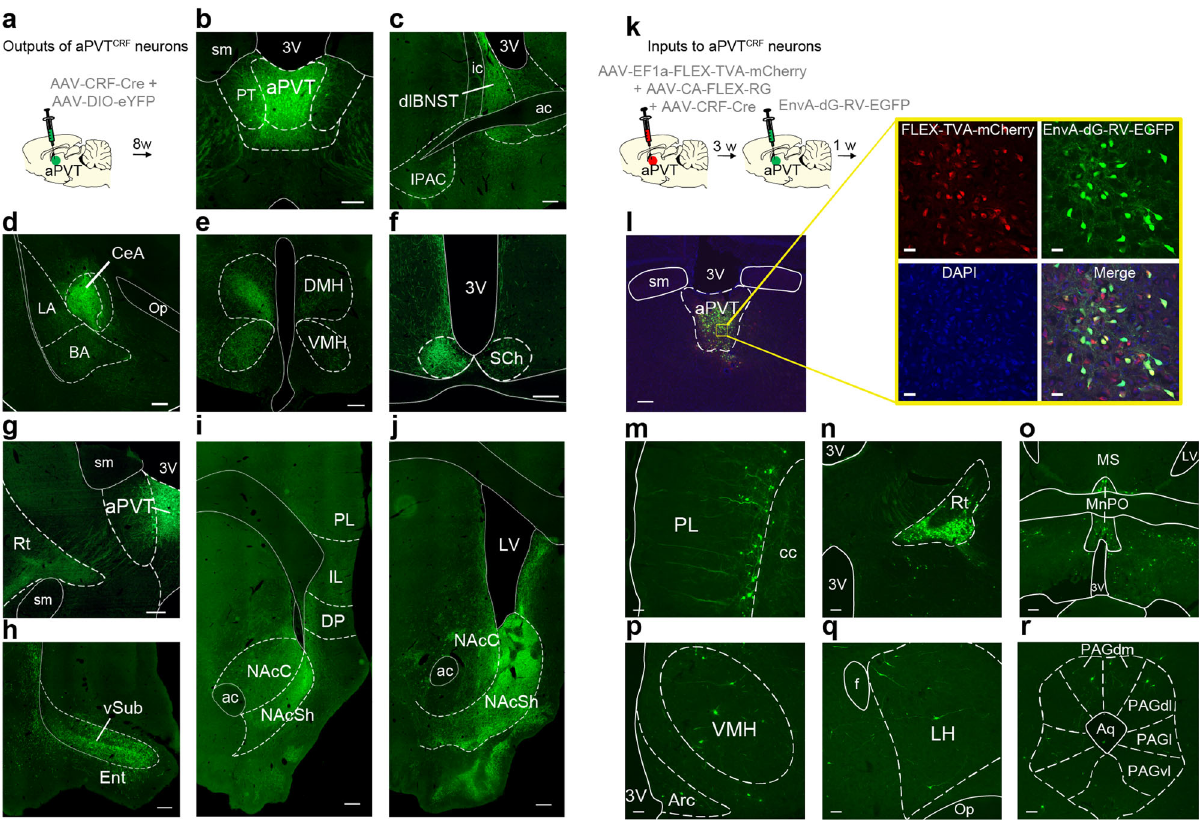
Fig. 6 Afferent and efferent connections of aPVT CRF neurons across the brain. a Schematic of intra-aPVT microinjection of a viral mix containing AAV- CRF-Cre and AAV-DIO-eYFP for speci fi c labeling of aPVT CRF neurons and their fi bers in output regions. b – j Representative micrographs showing the expression of eYFP in b aPVT CRF neurons and their GFP-labeled fi bers located in the c dorsolateral subregion of the bed nucleus of stria terminalis (dlBNST), d central nucleus of the amygdala (CeA), e dorsomedial hypothalamus (DMH), and ventromedial hypothalamus (VMH), f suprachiasmatic nucleus of hypothalamus (SCh), g reticular thalamic nucleus (Rt), h ventral subiculum (vSub), and both i the anterior and j the posterior subregions of the nucleus accumbens shell (NAcSh). Scale bars: 500 μ m. This experiment was repeated in three rats with similar results. k Diagram of the viral vector infusions used for monosynaptic retrograde tracing of aPVT CRF neurons. l Representative micrograph of the injection site in aPVT showing the expression of helper virus (red) and rabies virus (green) under the control of AAV-CRF-Cre virus. Scale bar: 200 μ m. Inset: High magni fi cation of the